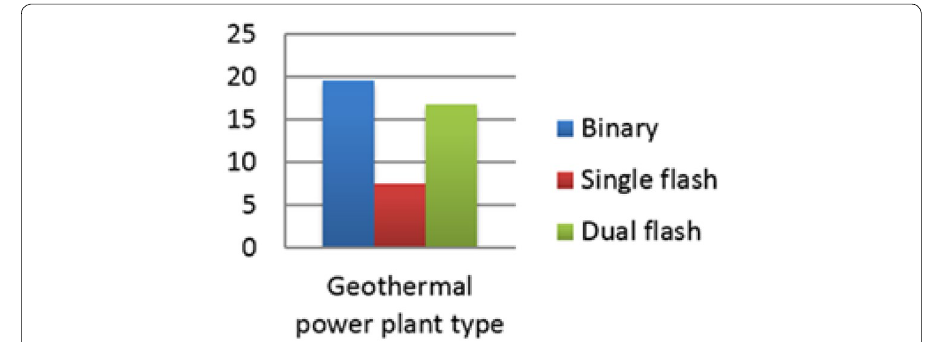
Fig. 17 Power factor at 80% contribution for three different power